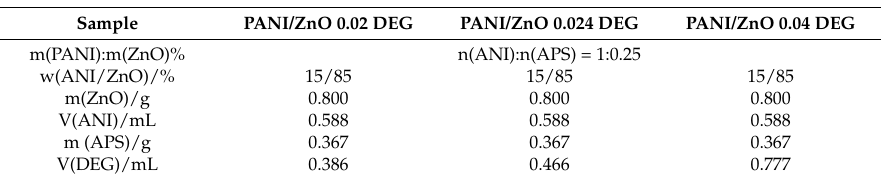
Table 1. The components used for the preparation of the polyaniline/zinc oxide (PANI/ZnO) composite photocatalysts.